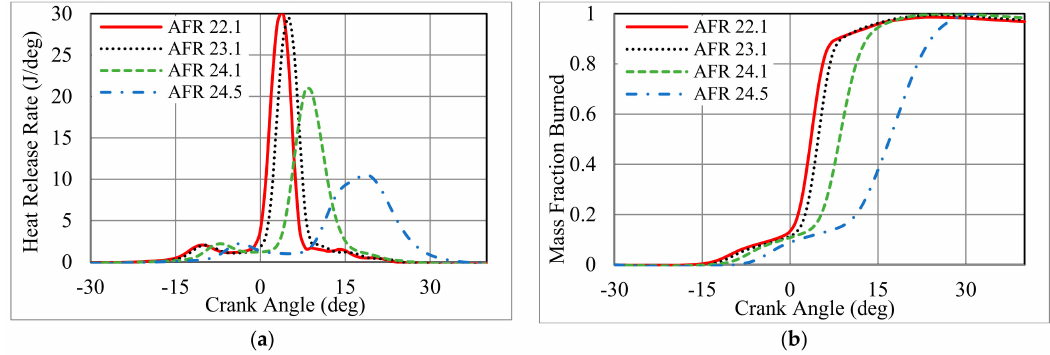
Figure 5. Cylinder gas pressure and temperature with various AFR s: ( a ) pressure; and ( b ) temperature.